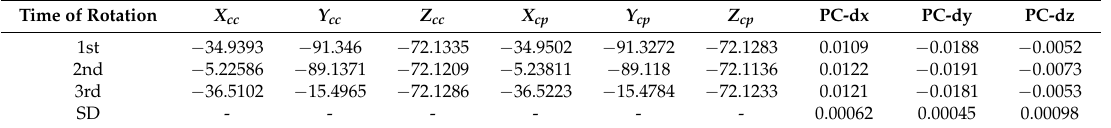
Table 5. Offsets from the CC to the TP (unit: